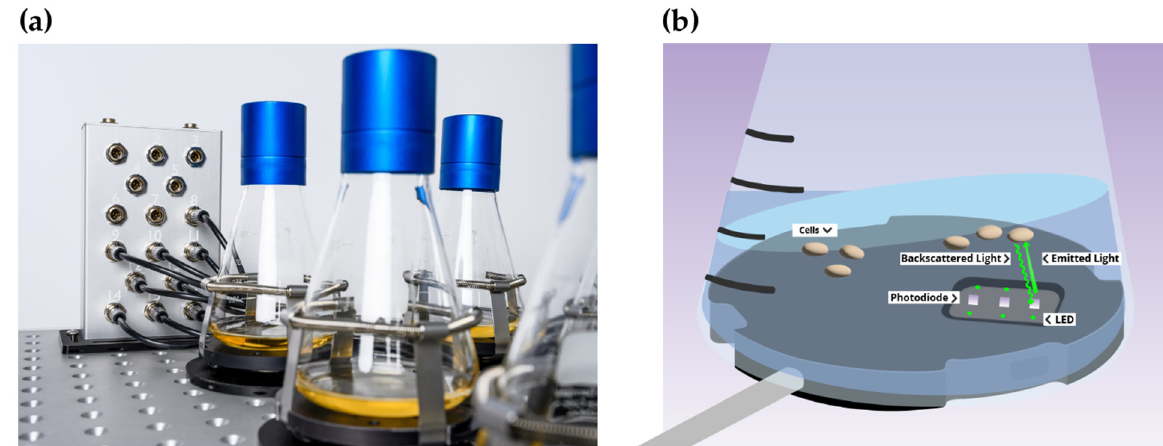
Figure 1. The CGQ-measurement principle. ( a ) CGQ sensors are mounted underneath the shake flasks for non-invasive measurements through the glass wall of the vessel. The sensors are connected to a base station that communicates the data to a computer outside of the incubator. ( b ) Biomass measurements are mediated via backscattered light detection. An LED emits light into the medium, which is scattered by cells/pellets/particles within the culture. A portion of the scattered light is detected as backscatter by a photodiode that is part of the CGQ sensor. With higher cell densities the backscattered light intensity is higher compared to lower cell